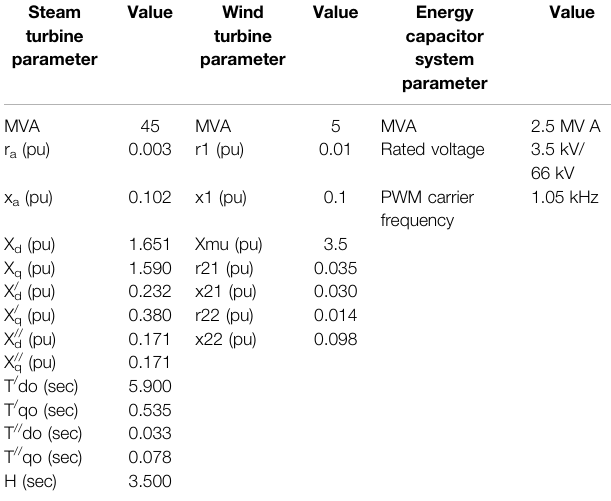
TABLE 1 | Turbine and energy capacitor